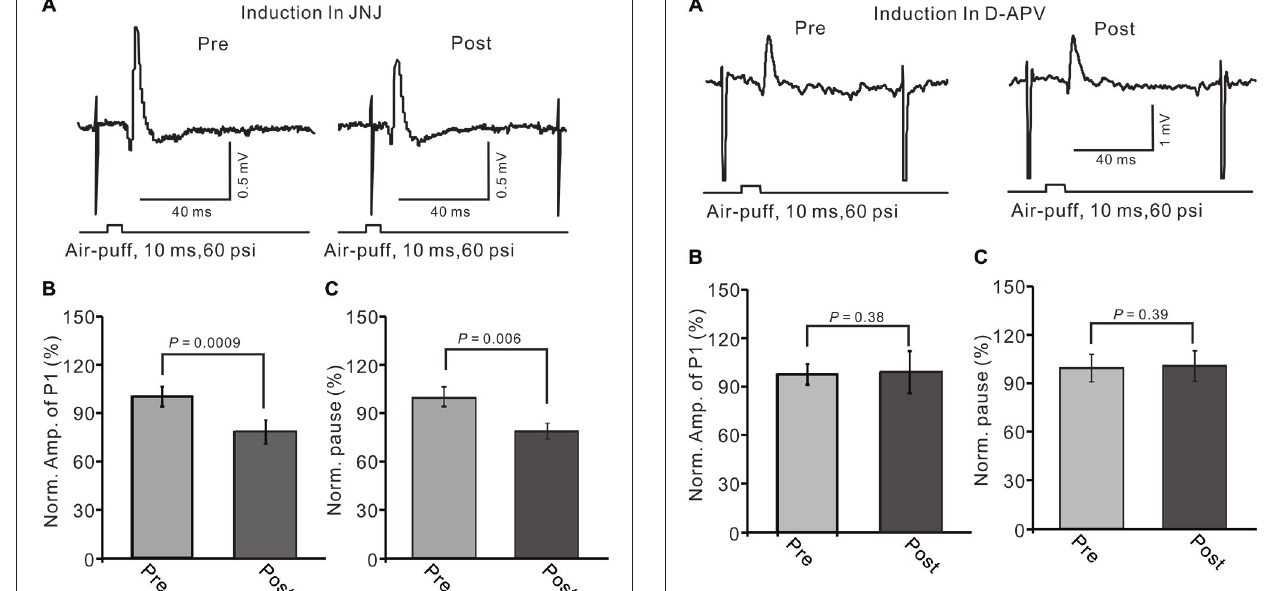
FIGURE 8 | Blocking metabotropic glutamate receptor 1 (mGluR1) during 1 Hz stimulation failed to prevent the LTD of GABAergic transmission at PCs . (A) Upper, representative cell-attached recording traces showing air-puff stimulation (10 ms, 60 psi)-evoked responses in a PC before (pre) and after (post) 1 Hz (240 pulses) stimulation delivered in the presence of mGluR1 antagonist, JNJ16259685 (10 µ M, right panel). (B) Summary of data showing normalized amplitude of P1 before (pre) and after (post) delivery of 1 Hz (240 pulses) stimulation. (C) Pooled data showing the normalized pause of SS firing before (pre) and after (post) delivery of 1 Hz (240 pulses) stimulation. Note that the amplitude of P1 was still depressed after 1 Hz stimulation without mGluR1 activity.